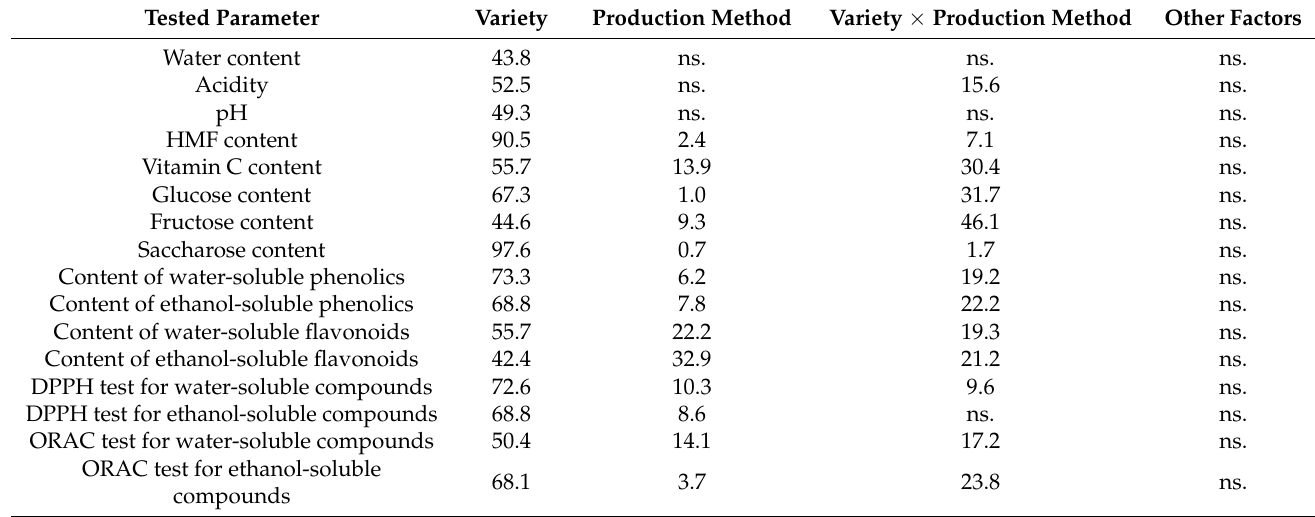
Table 6. Effect of variety and production method (% of explained variance) on tested parameters in honeys.